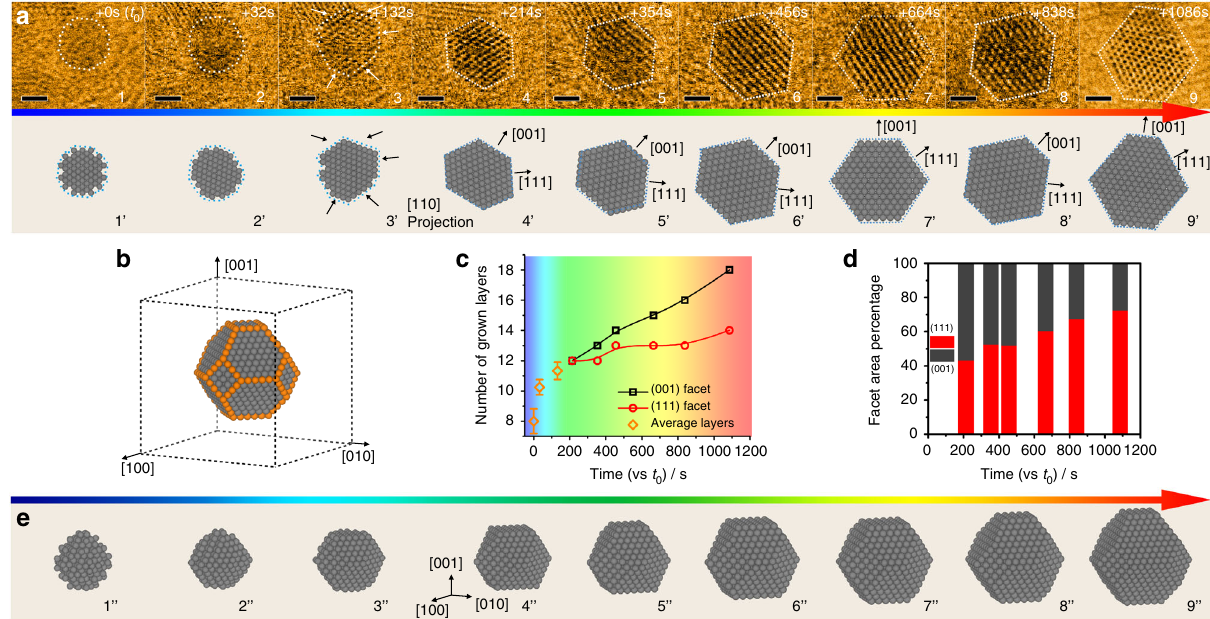
Fig. 1 Shape evolution of the growing Pt 3 Ni nanoparticle. a In situ STEM images of one growing Pt 3 Ni nanoparticle (upper row) and corresponding 2D projection model (lower row), scale bar: 1 nm. b Representative atomic model (not to scale) of the nanoparticle during growth. c Number of grown layers of the (001) and (111) facets (Error bars correspond to standard deviations of at least three independent layer estimation) and d their surface exposure ratio as function of experimental time. e 3D model (not to scale) of the Pt 3 Ni growth process. The early stage model 1 ” is only constructed to show a possible dynamical cluster